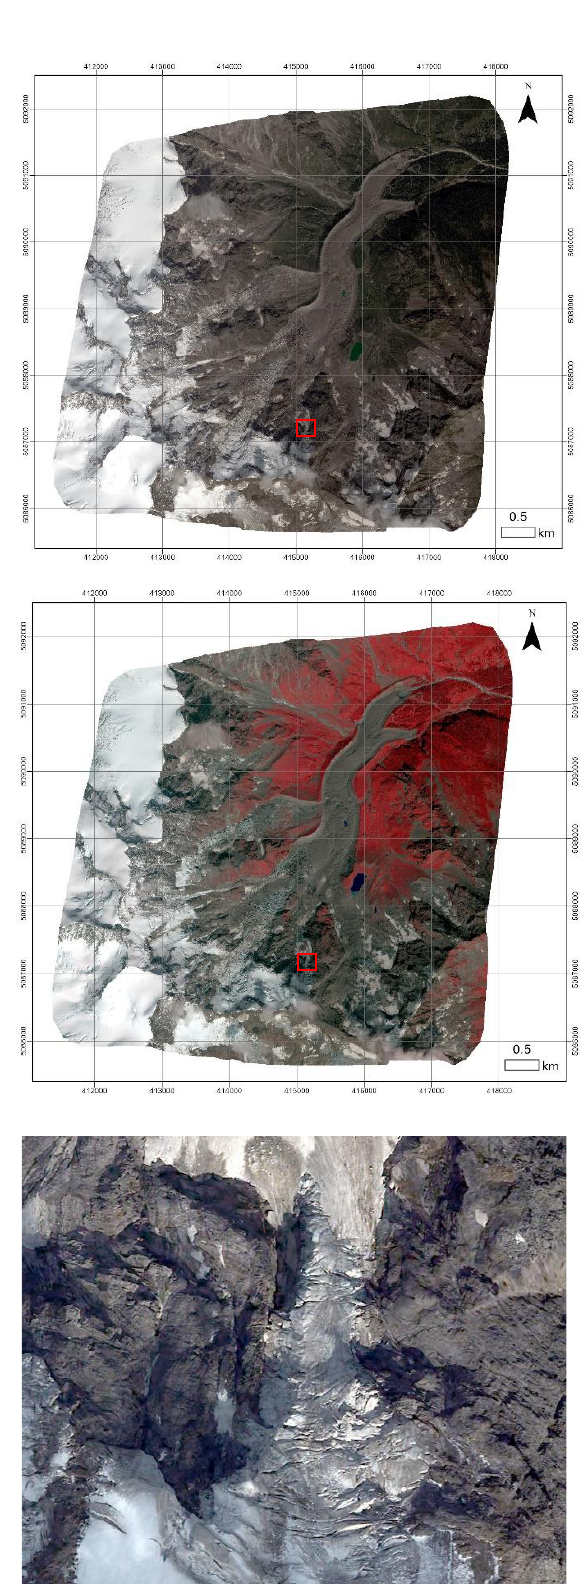
Figure 5. True color orthoimage (top), False color (NIR) orthoimage (center) and 1:1 True color detail (bottom) covering Belvedere glacier based on satellite stereo pair using the satellite DSM as ancillary elevation dataset . GSD = 0.5 m (UTM projection, Zone 32N, Datum